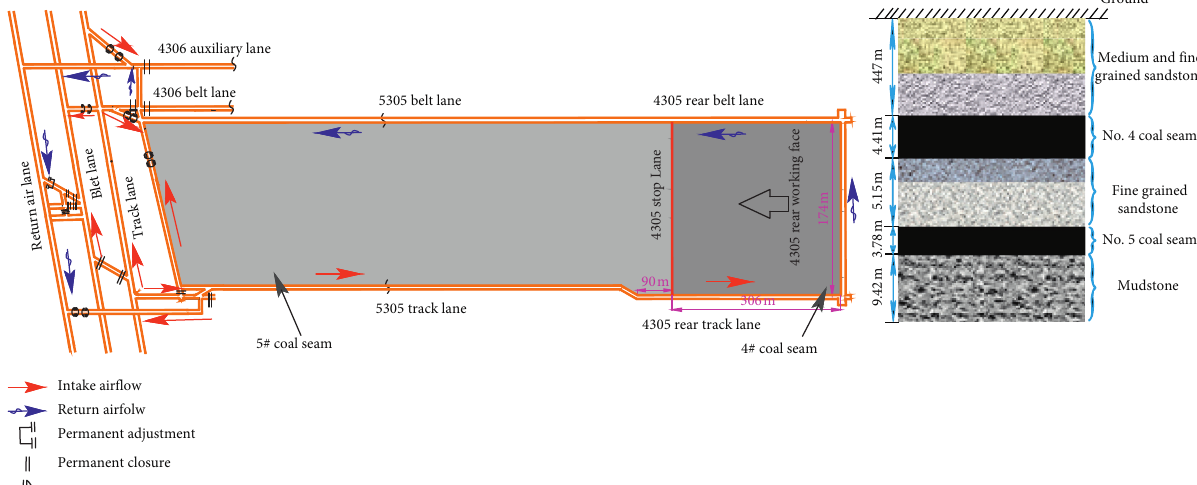
Figure 1: Layout of the working face and lithologic characteristics of overlying strata.